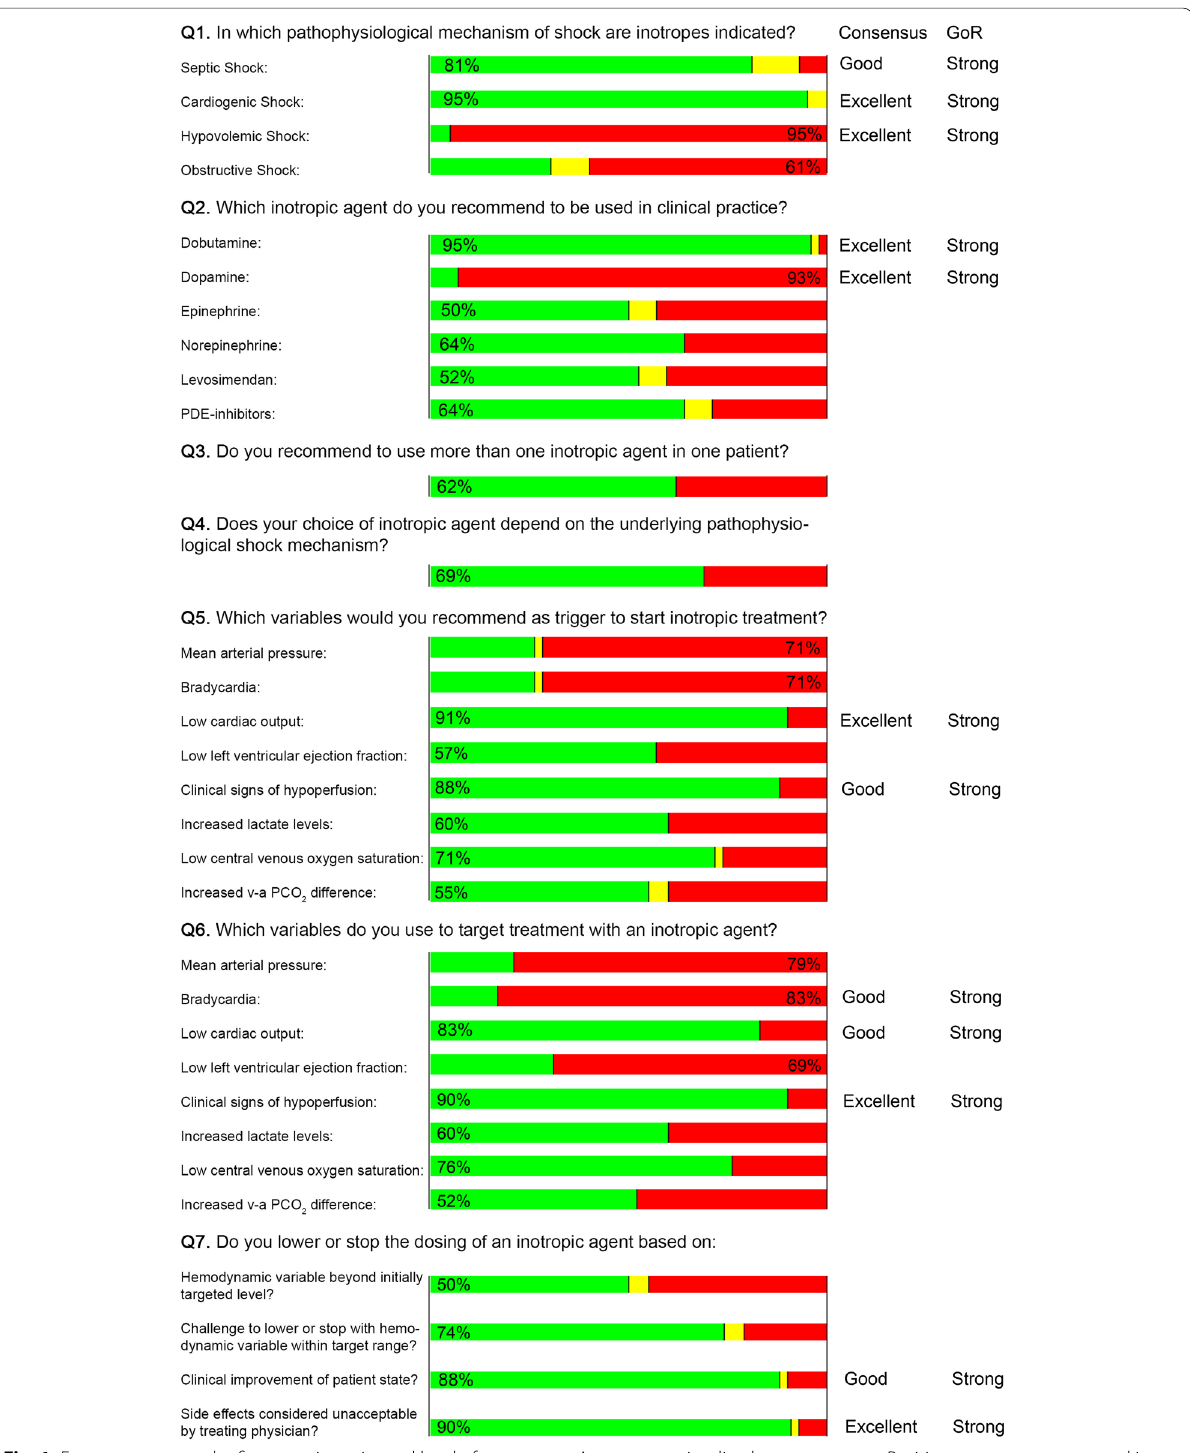
Fig. 1 Expert answers to the first questionnaire and level of agreement. Answers are visualized as percentages. Positive answers are presented in green, conditional answers are presented in yellow, negative answers are presented in red. PDE phosphodiesterase, v-a PCO 2 veno‑arterial PCO 2 difference, GoR grade of